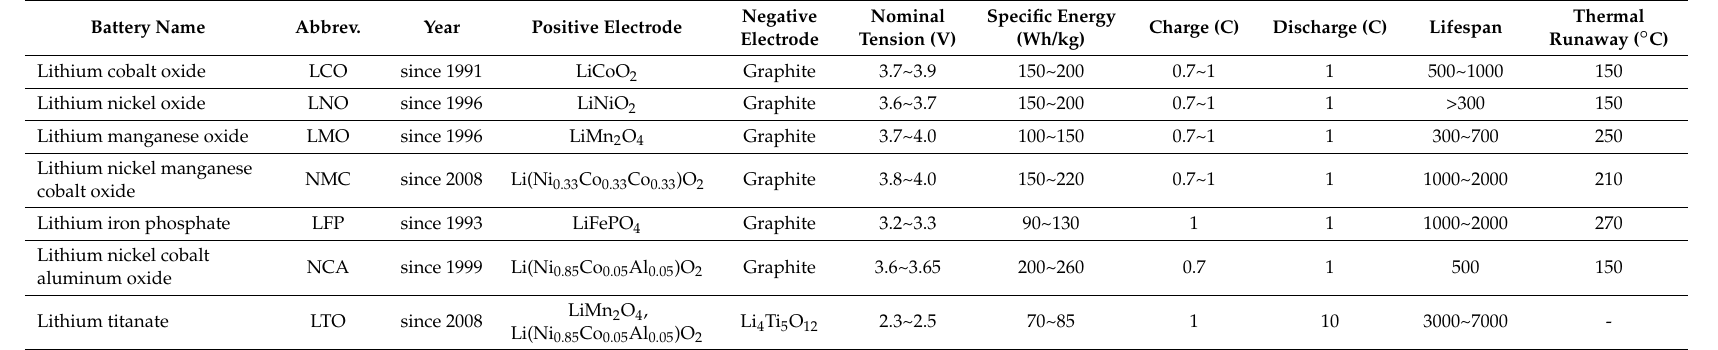
Table 1. Comparison of various commercial lithium-ion batteries